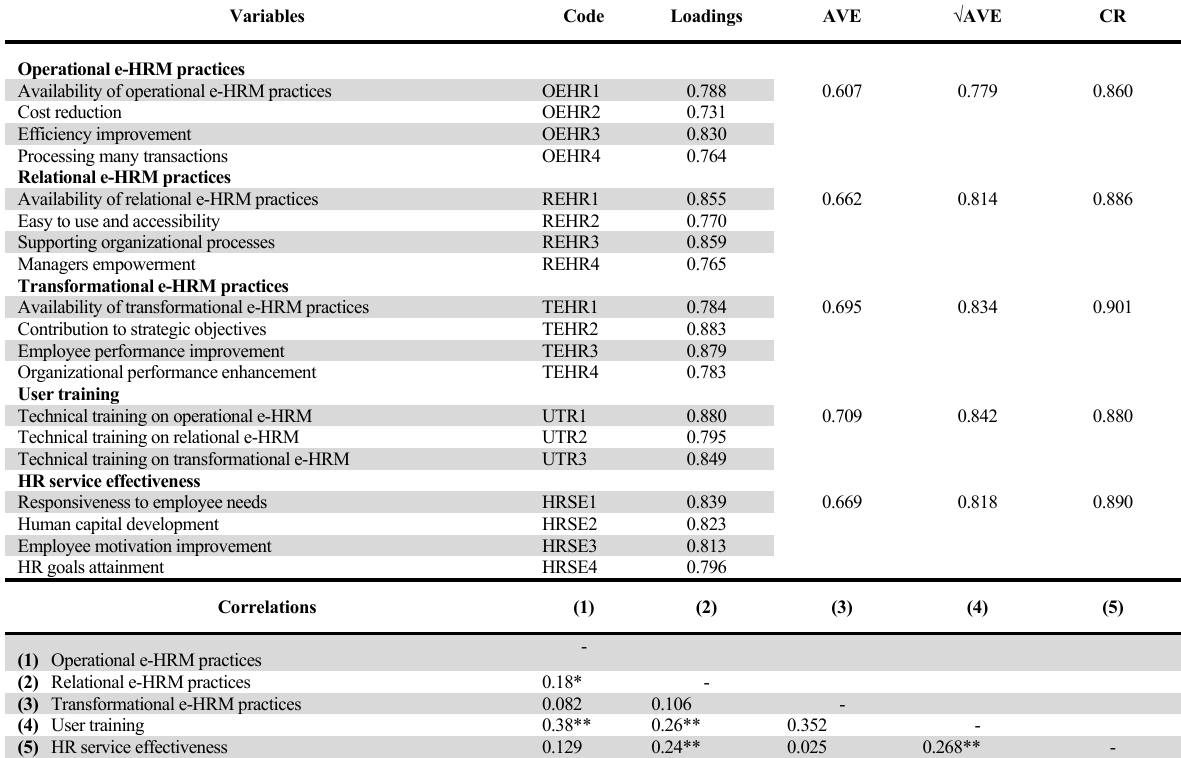
Research measures and results of exploratory factor analysis Variables